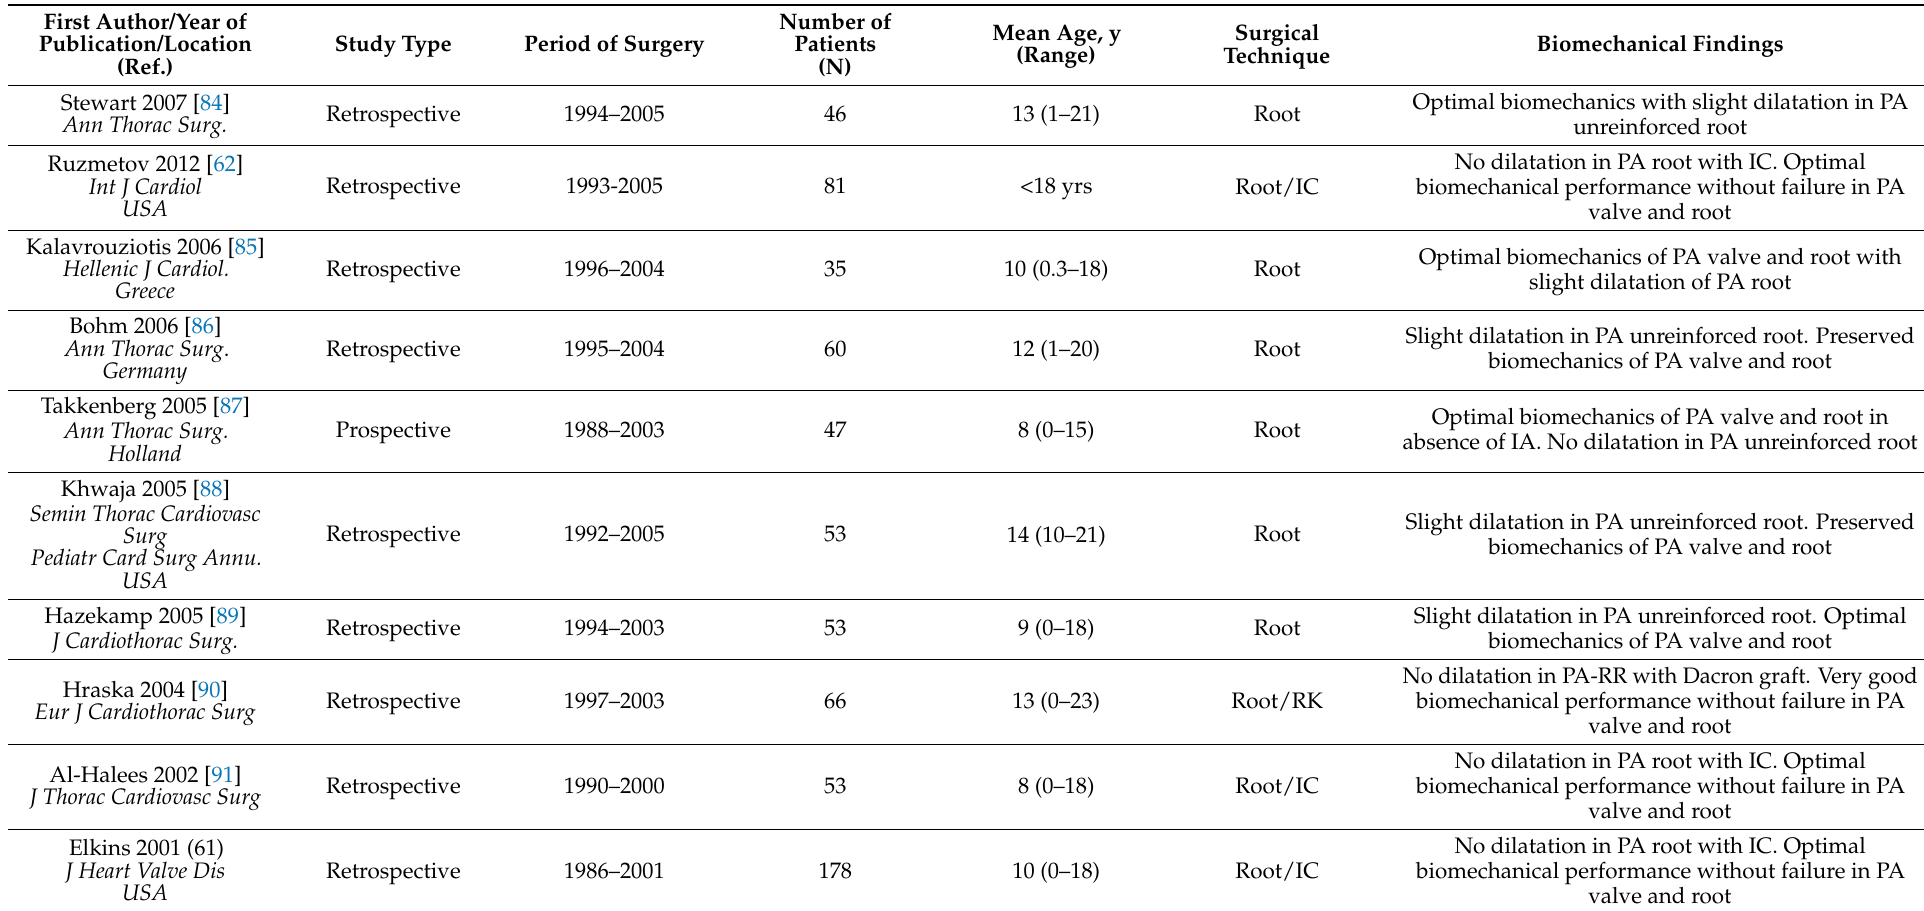
Table 2. Overview of studies obtained by systematic review reporting pediatric series of Ross